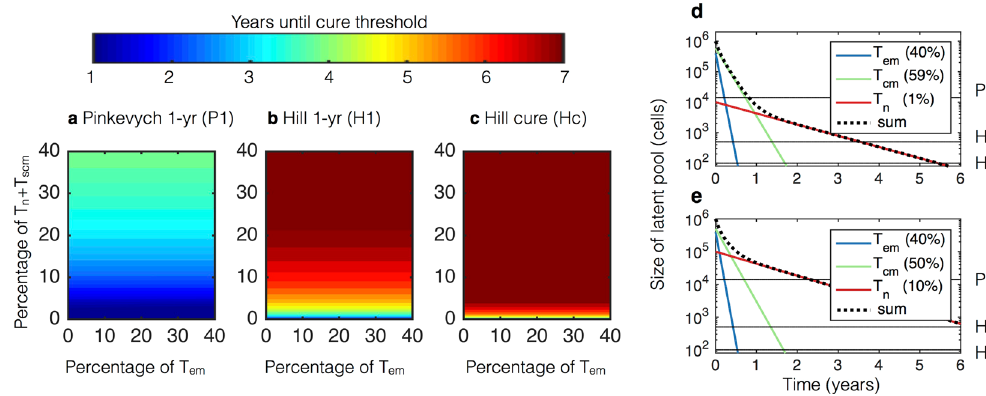
Figure 3. Simulated comparisons of anti-proliferative therapies on standard antiretroviral therapy (ART) assuming variable reservoir composition. Proliferation and death rates in Table 1. The potency of the therapy is ε AP = 10 ( i . e ., each cell type i has proliferation rate equal to α ∈ i [em, cm, n] ). Plausible initial i /10 with compositions of the reservoir ( L i (0)) are taken from experimental measurements 6, 12, 23 . It is assumed that the HIV activation rate ξ is equivalent across all reservoir subsets. ( a – c ) Plots of times to therapeutic landmarks on long-term ART and anti-proliferative therapy with heterogeneous reservoir compositions consisting of effector memory (T em ), central memory (T cm ), and naïve plus stem cell-like memory (T n + T scm ) CD4 + T cells. T em and T n + T scm percentages are shown with the remaining cells representing T cm . Times to one-year remission and functional cure are extremely sensitive to percentage of T n + T scm but not percentage of T em . ( d , e ) Continuous 10-fold therapeutic decreases in all proliferation rates ( α i ) result in Hill 1-yr in ( d ) 3.5 years assuming T n + T scm = 1% and ( e ) 6 years assuming T n + T scm = 10%. The reservoir is predicted to become T n + T scm dominant within 2 years under both assumptions, providing an indicator to gauge the success of anti- proliferative therapy in potential